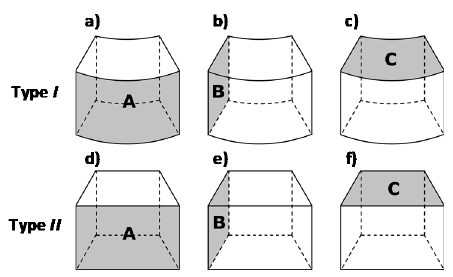
Figure 3. Surface areas present applying the discrete-ordinates method for a semi-cylindrical enclosure with a present bed material for cell types I ( a – c ) and II ( d – f ). Defining the cells from a line between the center of the furnace and the middle of the bed surface, in the angular direction, (cid:1870) (cid:3041) is the shortest distance from the central axis of the kiln to the bed (cid:3293) ,(cid:3030) surface. Each cell surface may then be expressed as: